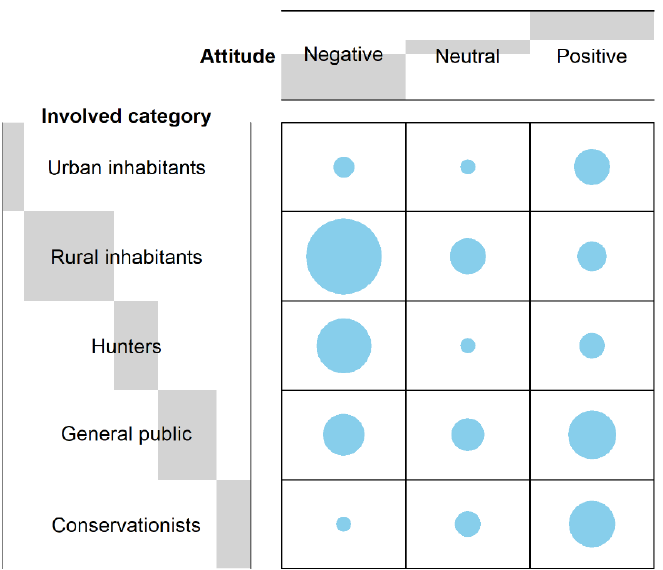
Figure 3. Contingency table showing the distribution frequency as far as the attitude towards carnivores of each category involved is concerned, i.e., urban inhabitants, rural inhabitants (mainly farmers and livestock owners), hunters, general public, conservationists. The size of the grey bars depends on the number of responses obtained by each stakeholder category for each attitude. For instance, from the above figure we see that the grey bar for rural inhabitants is the largest. This is because the highest number of responses were obtained (negative = 27, neutral = 6, positive = 4). On the contrary, the grey bar for urban inhabitants is the smallest as the lowest number of responses were obtained (negative = 2, neutral = 1, positive = 6). As far as the attitude is concerned (i.e., negative, neutral, positive), the criterion is the same. The negative attitude is that one which showed the larger grey bar as was that one mentioned the most by all stakeholders (urban inhabitants = 2, rural inhabitants = 27, hunters = 14, general public = 8, conservationists = 1). Contrarywise, the neutral attitude showed the smallest grey bar as the lesser mentioned by the stakeholders (urban inhabitants = 1, rural inhabitants = 6, hunters = 1, general public = 5, conservationists = 3).